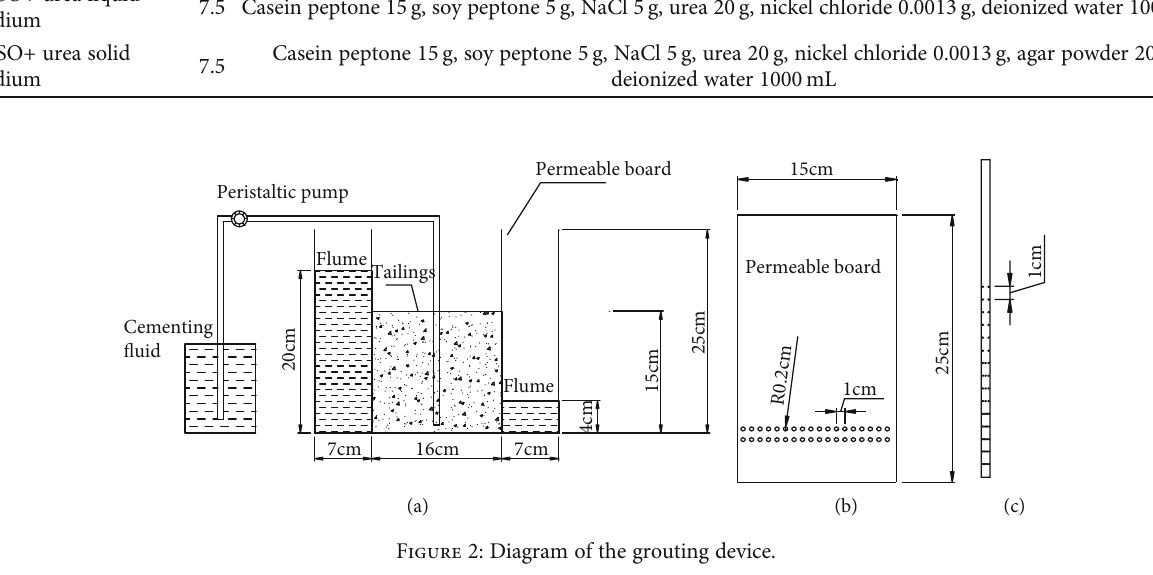
Figure 2: Diagram of the grouting device.